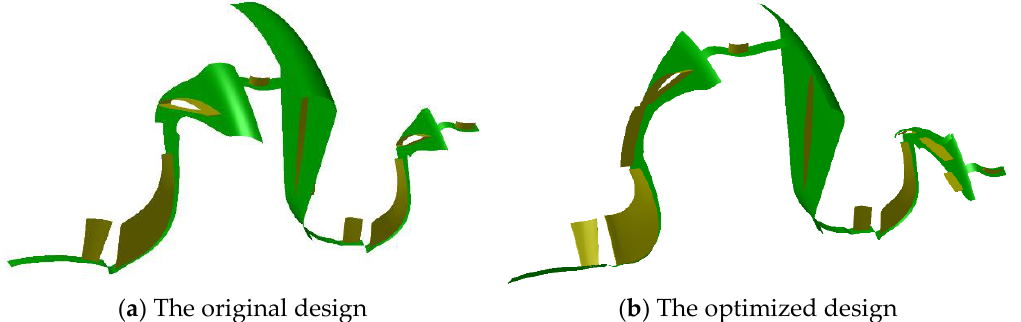
Figure 13. Geometric structure. Table 5. Parameters of circular calculation.